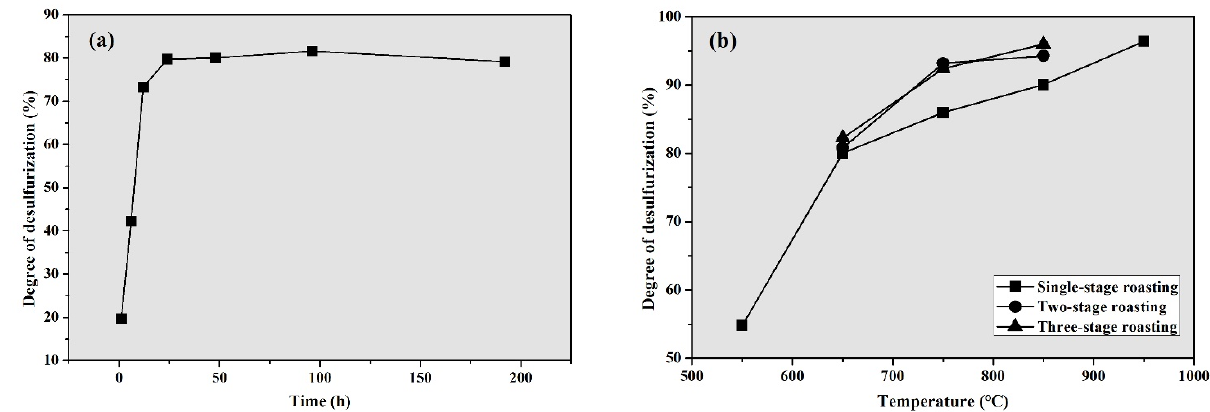
Figure 7. Degree of desulfurization of the products obtained under different conditions. ( a ) Products roasted at 650 °C for different roasting times, ( b ) products roasted for 48 h at different temperatures.